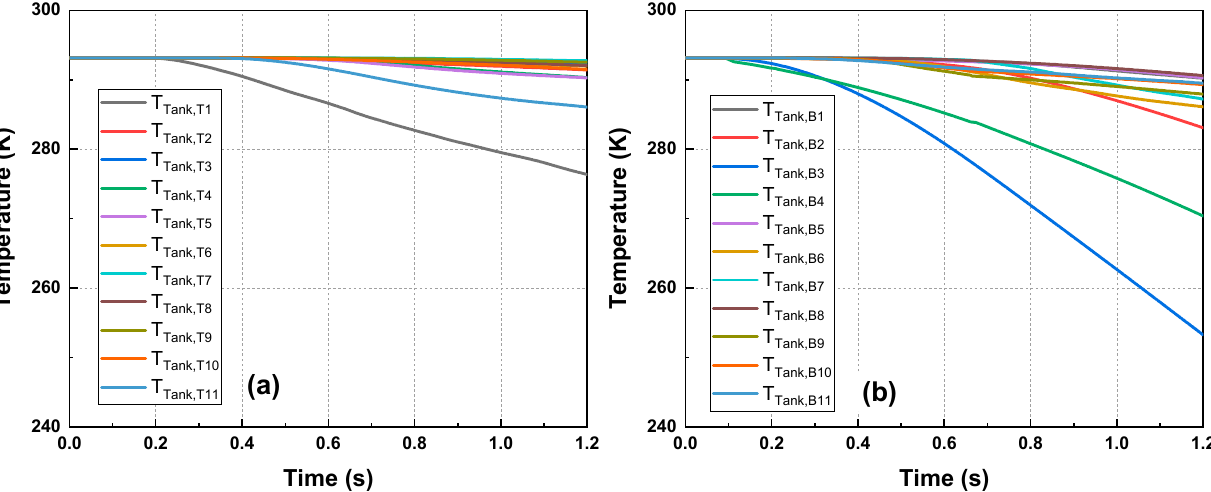
Figure 15. Variations in tank temperature according to charging process for ( a ) the top of the tank, and ( b ) the bottom of the tank.